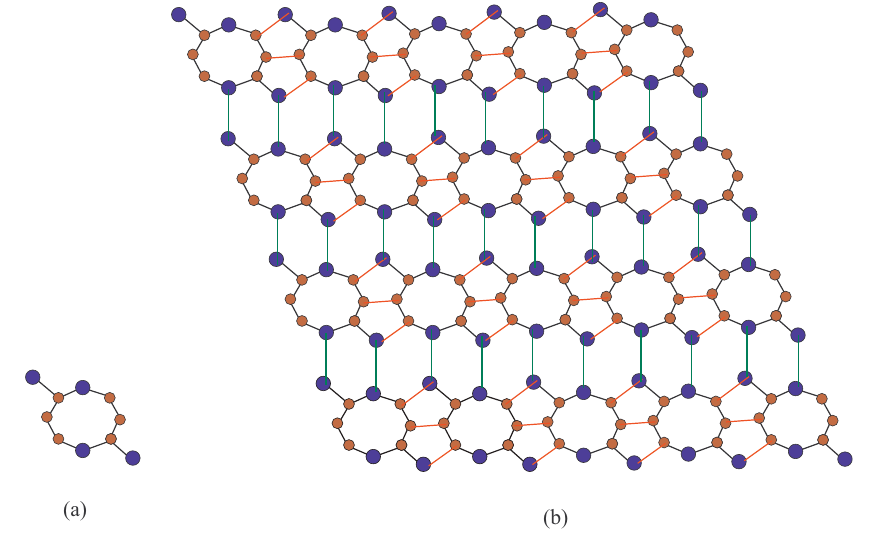
Figure 1: ( a ) Unit cell of Si C 2 3 - n m III , [ ] , ( b ) Si C 2 3 - III [ 5,4 ]